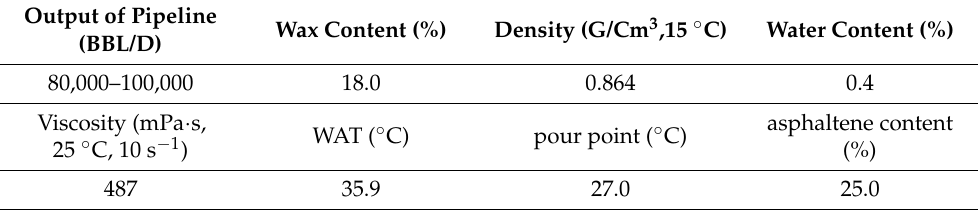
Table 1. The elemental physical properties of African pipeline